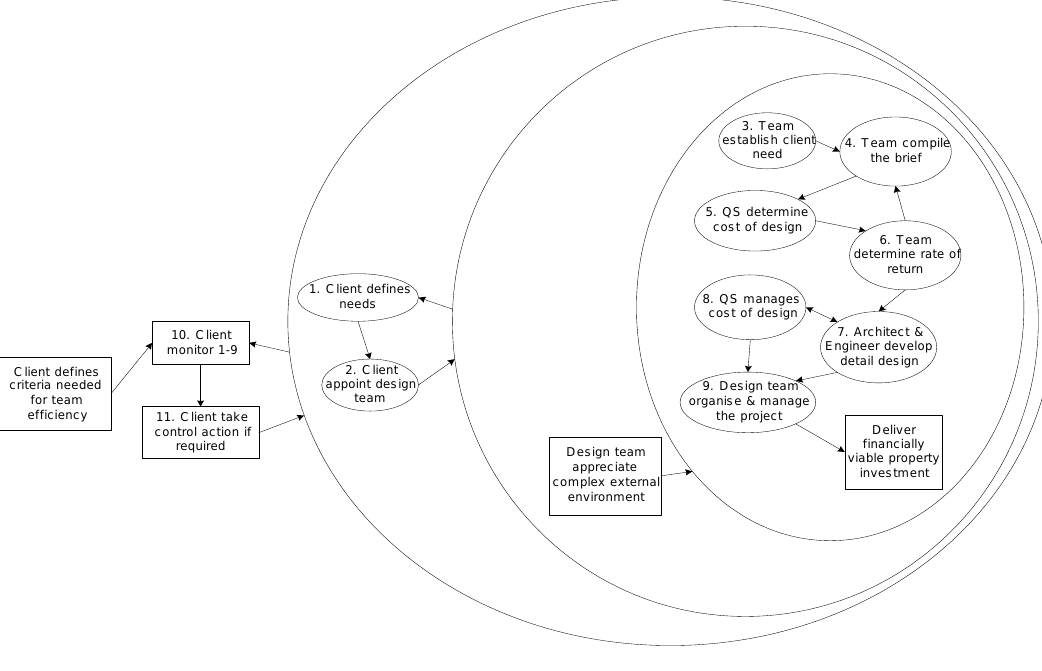
Figure 2 Conceptual model for the cost management system in the ‘real